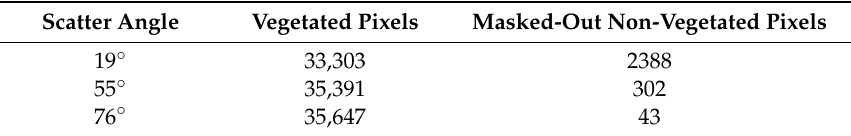
Table 3. Number of pixels with values observed from three different viewing angles. Total number of pixels in the polygon was 35,691 for 𝛽 = 19 , 35,693 for 𝛽 = 55 , and 35,690 for 𝛽 = 76 . Scatter Angle Vegetated Pixels Masked-Out Non-Vegetated Pixels 19° 33,303 2388 55° 35,391